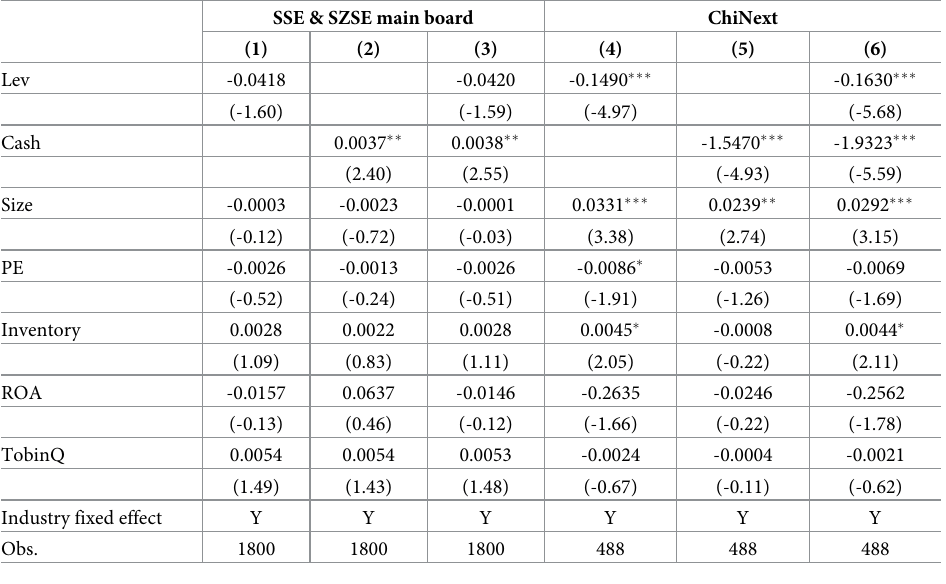
Table 7. Subsample regression results: SSE & SZSE main board and